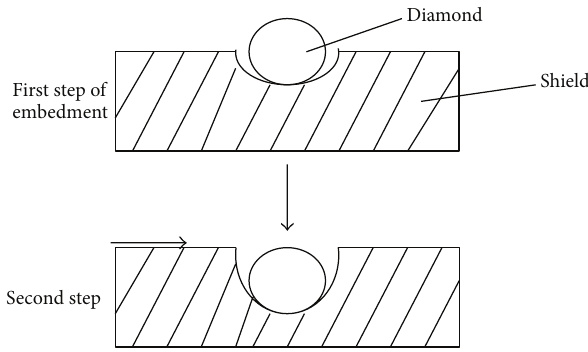
Figure 3: Modeling of the embedment of a single nanodiamond. deformation. When the tough circle radius is the same as the diamond radius, the diamond is embedded into the shield.